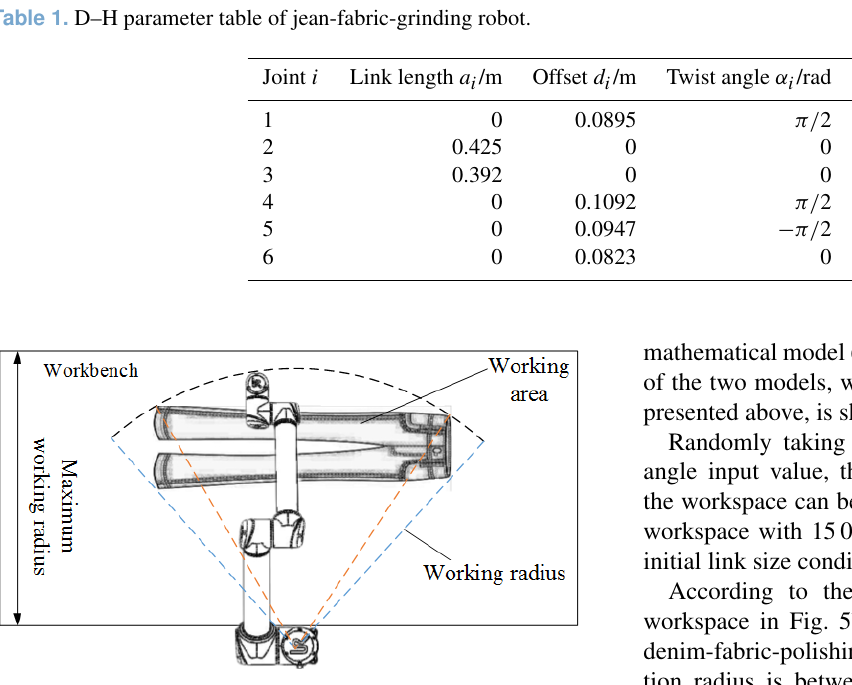
Figure 2. Schematic workspace diagram of denim-polishing pro-